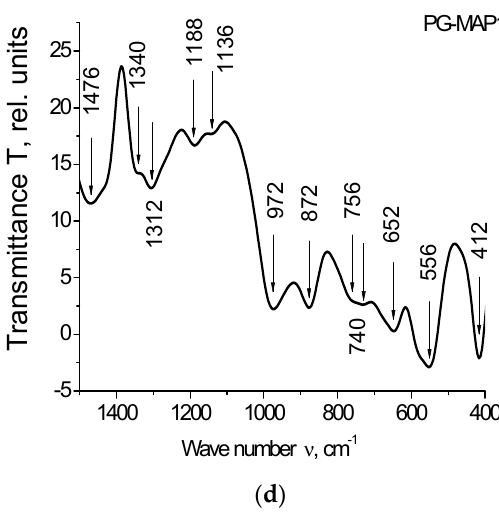
Figure 4. IR spectra of the PG-matrix (PG MAP) and composites (PG-MAP05 and PG-MAP1) in the spectral range ( a ) (4000–400) cm − 1 , ( b – d ) (1500–400) cm − 1 .